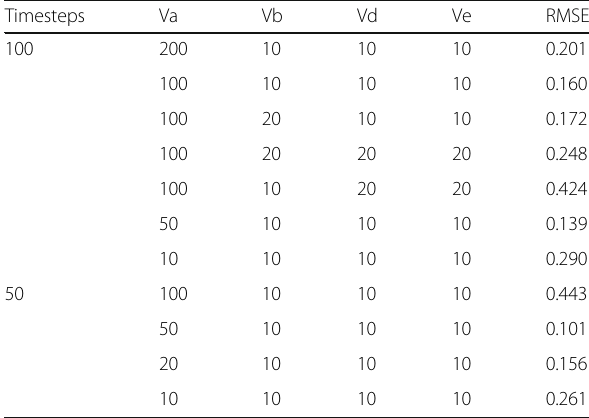
Table 5 Prediction deviation of multi-node multi-feature